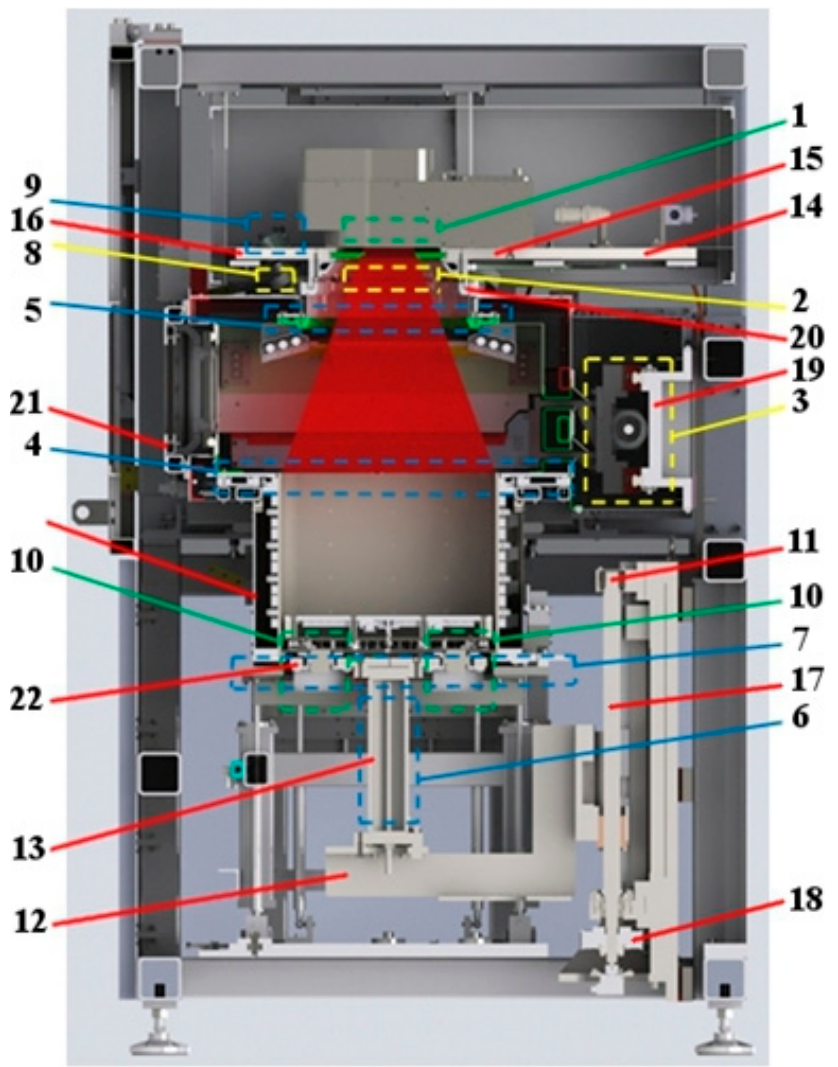
Figure 5. Cooling circuits of the SLS machine (cross-section of the Figure 3b). Different indicator colors correspond to the selected cooling circuit: water—blue, nitrogen—yellow, air—green, control points—red color.